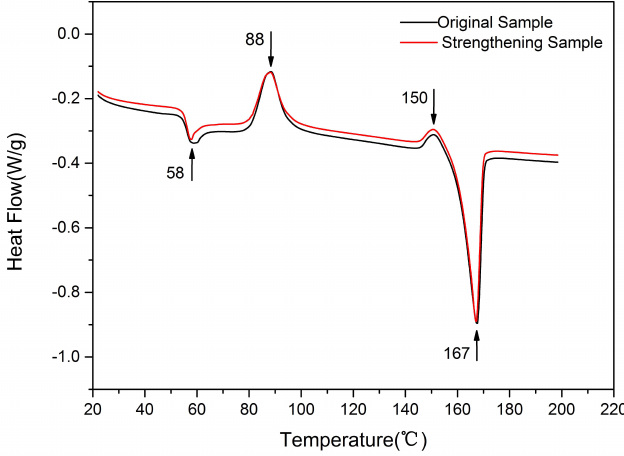
Figure 8. DSC patterns of the original and ultrasonic-strengthened PLA samples.